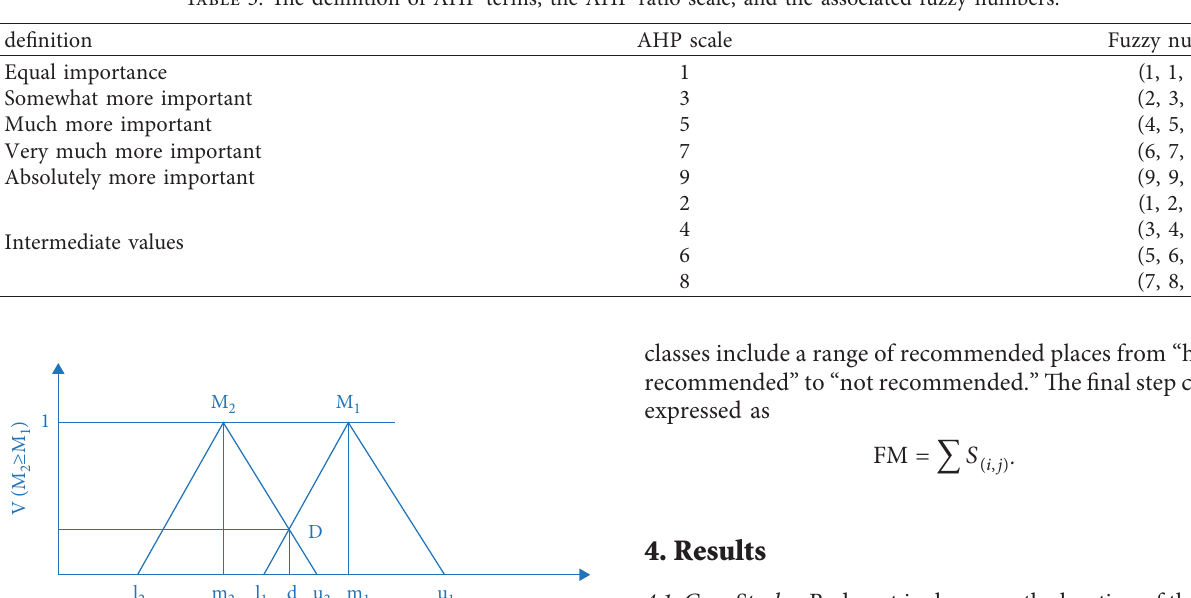
Table 3: The definition of AHP terms, the AHP ratio scale, and the associated fuzzy numbers.